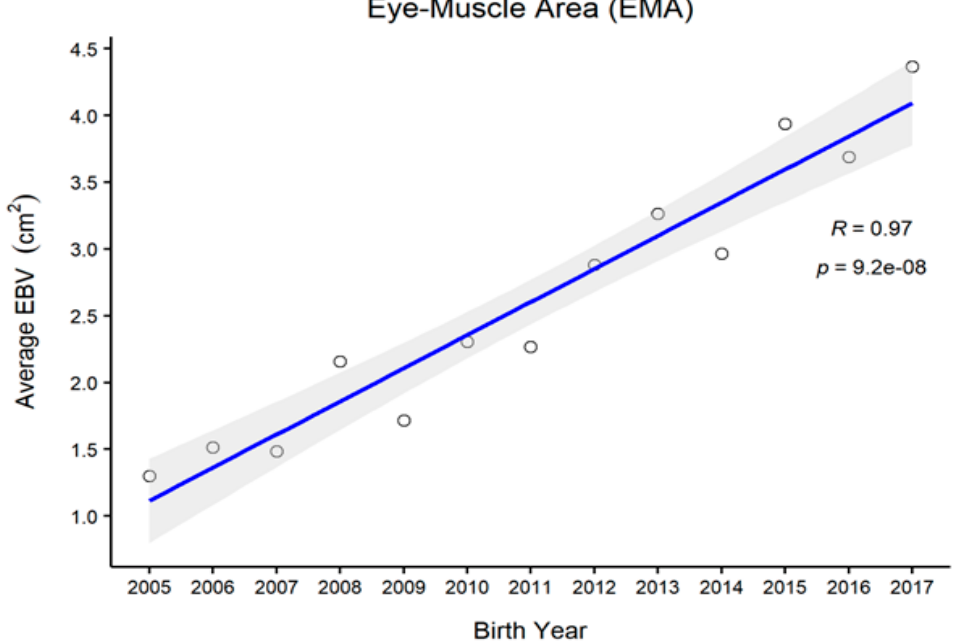
Figure 2. The genetic trend of estimated breeding values (EBVs) of the eye muscle area of Hanwoo males from the 30-month production system (R, Pearson’s correlation coefficient; p , the p -value of correlation